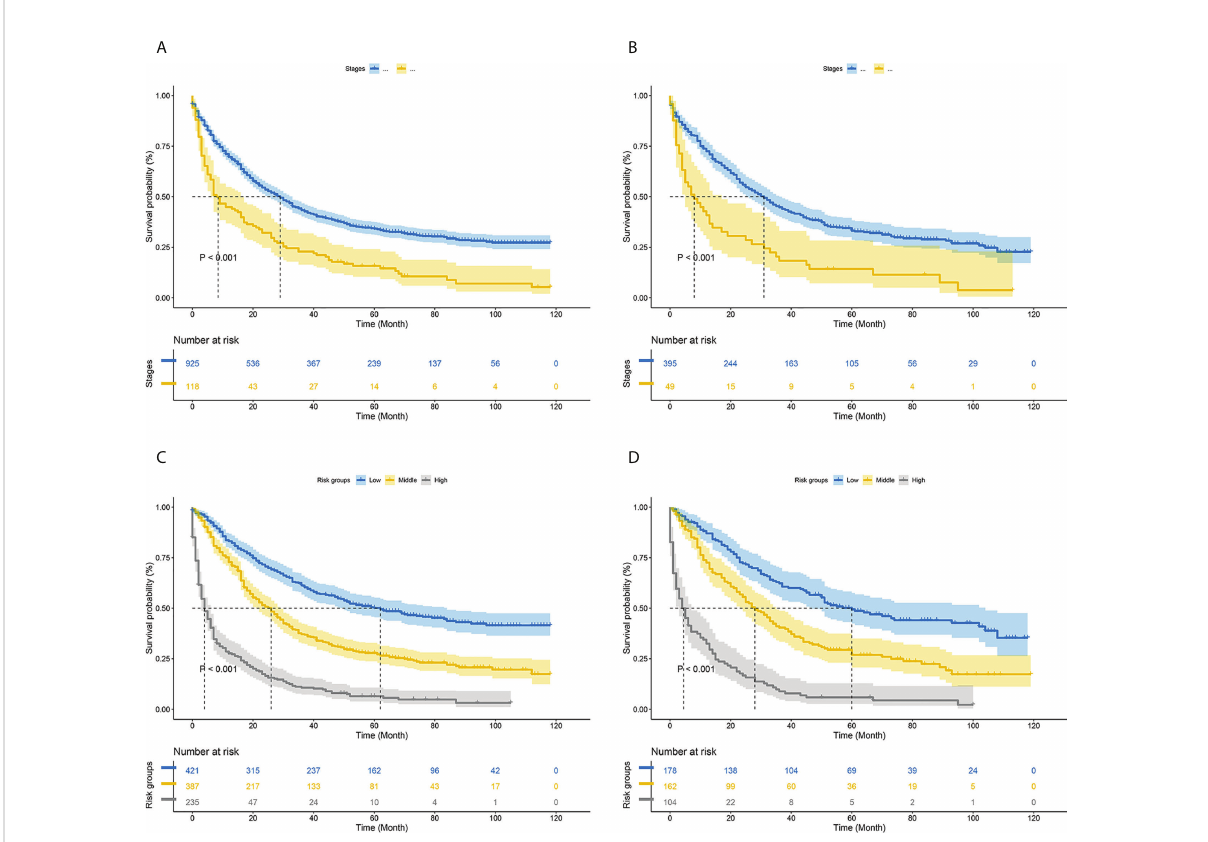
FIGURE 8 Kaplan – Meier curves of cancer-speci fi c survival for new risk classi fi cation and the AJCC tumor staging (A) The AJCC tumor staging in the training cohort; (B) The AJCC tumor staging in the validation cohort; (C) The new risk classi fi cation in the training cohort; (D) The new risk classi fi cation in the validation